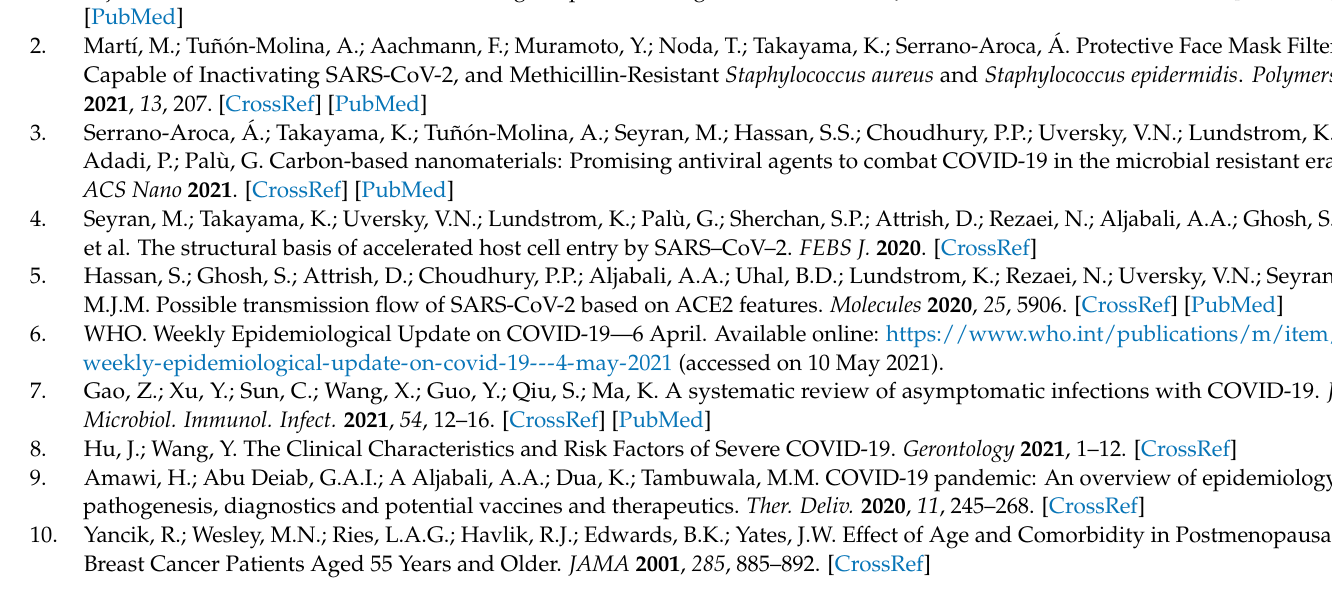
genes. (C) Identified targets and the FDA-approved drugs against these targets. Figure S4: Pathway crosstalks between CKDs and COVID-19. (A) The shared genes. (B) The hub-genes among the core 32 shared genes. (C) Identified targets and the FDA-approved drugs against these targets. Figure S5: Pathway crosstalks between CVDs and COVID-19. (A) The shared genes. (B) The hub-genes among the core 39 shared genes. (C) Identified targets and the FDA-approved drugs against these targets. Figure S6: Venn diagram showing the individual and common targets from shared pathways. The top 10 targets of each comorbid conditions associated with COVID-19 were used in this analysis. Figure S7: Individual and common targets from shared pathways and approved drugs against these targets. Figure S8: Venn diagram showing the individual and common targets from hub-gene analysis. The top 10 hub genes from each comorbid condition associated with COVID-19 were used in this analysis. Figure S9: Approved drugs associated with the hub-gene targets. Drugs for individual and combinations of comorbidities in COVID-19 are presented. Supplementary Table S1: Shared pathways and targets in diabetes and COVID-19. Supplement Table S2: Shared pathways and targets in hypertension and COVID-19. Supplementary Table S3: Shared pathways and targets in cancer and COVID-19. Supplementary Table S4: Shared pathways and targets in CKD and COVID-19. Supplementary Table S5: Shared pathways and targets in CVD and COVID-19. Supplementary Table S6: Hub-gene-based target